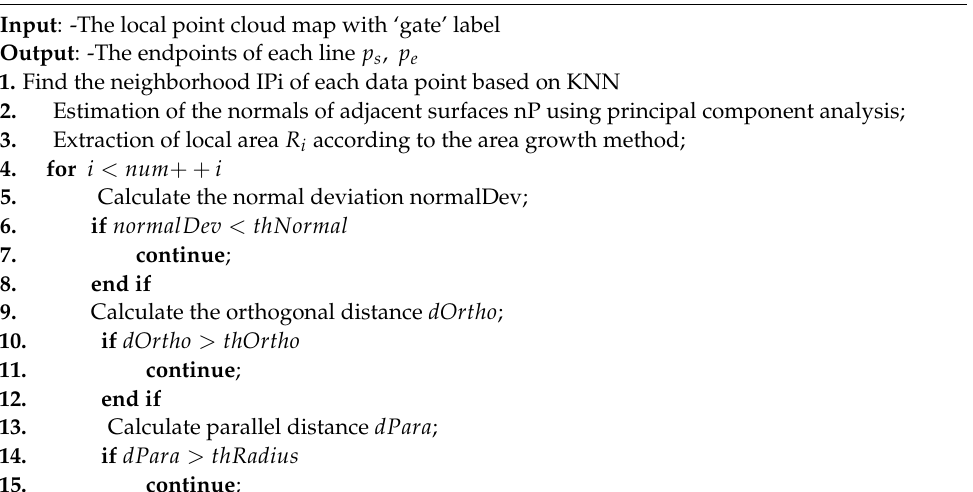
Algorithm 1: Image-based 3D line segment detection